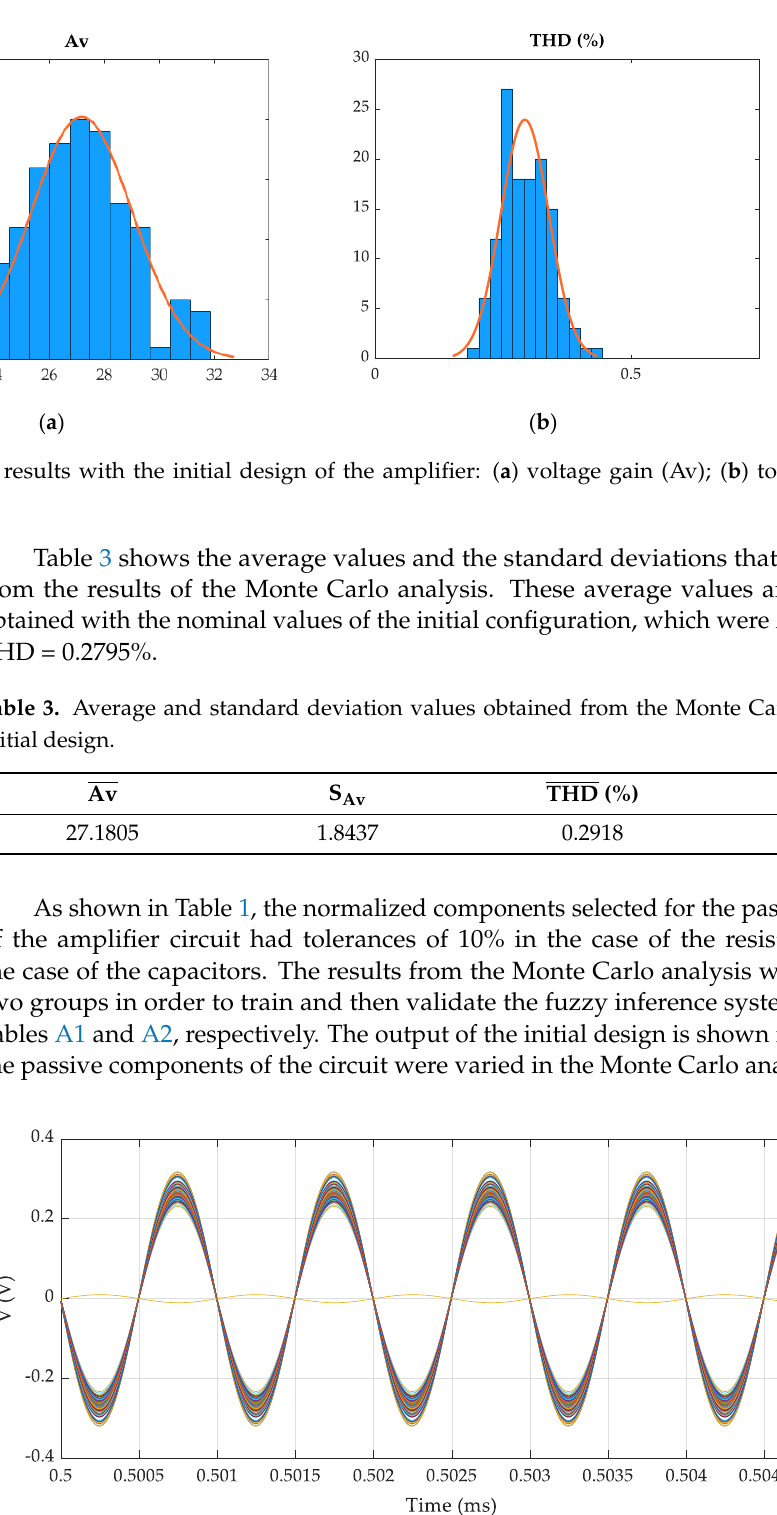
Figure 4. Response of the amplifier (Monte Carlo analysis).